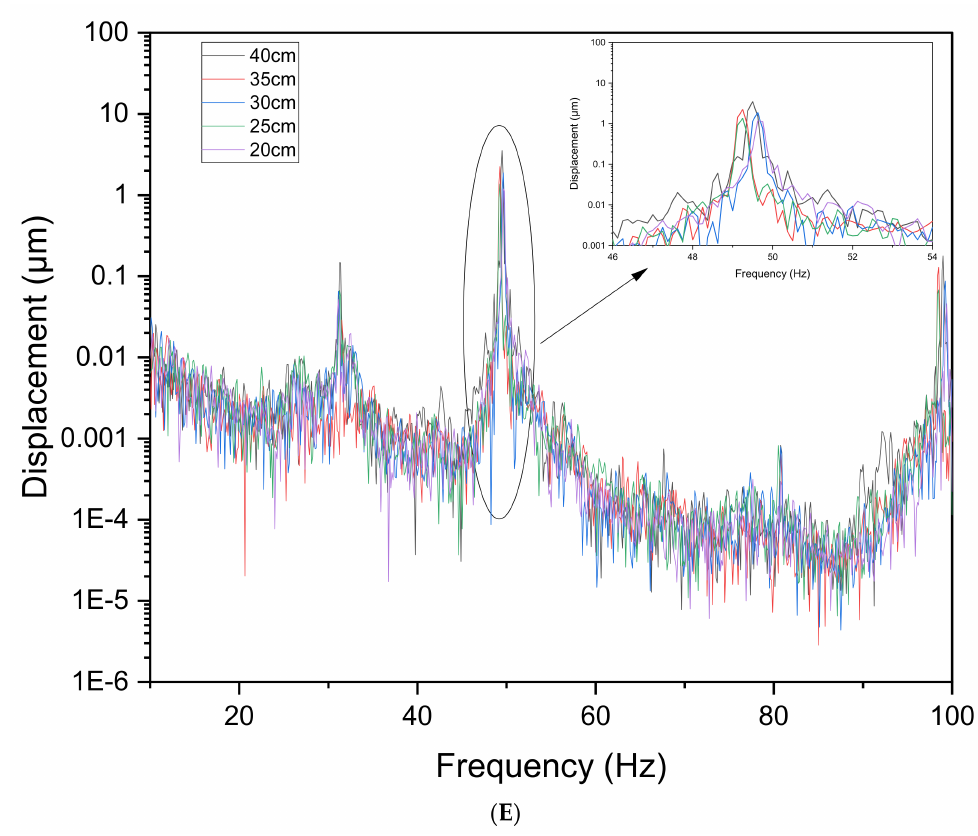
Figure 5. Influence of depth of granular fill (20–40 cm) on the displacement spectrum at an excitation frequency of ( A ) 10 Hz; ( B ) 20 Hz; ( C ) 30 Hz; ( D ) 40 Hz; ( E ) 50 Hz.